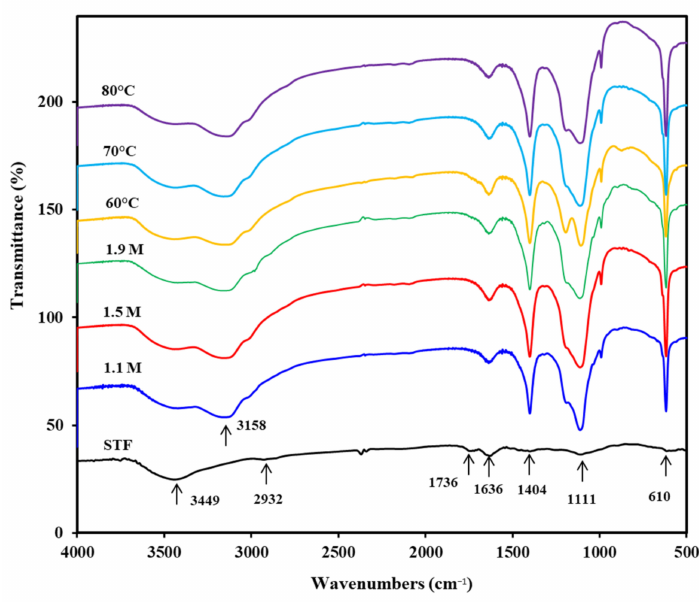
Figure 7. FTIR spectra of STFs and CNCs obtained under different APS concentrations at 70 ◦ C for 16 h and under different oxidation temperatures with a 1.5 M APS concentration for 16